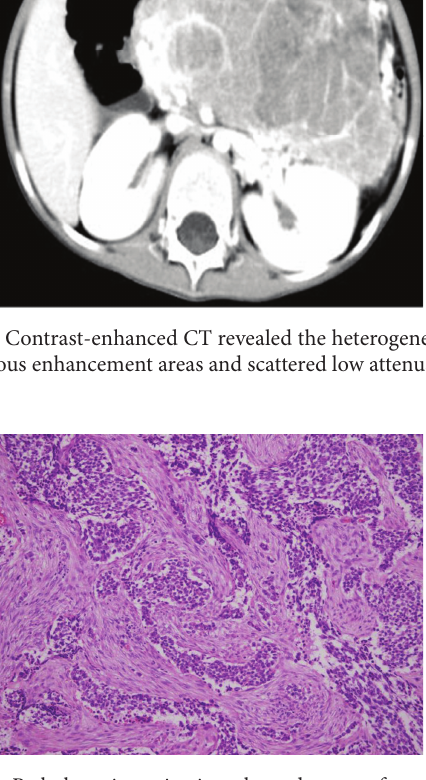
Figure 5: Pathology investigation showed nests of small, round undifferentiated cells separated by myxomatous desmoplastic stroma (haematoxylin-eosin stain, original magnification, × 20). radiographic method is CT scan with intravenous contrast.